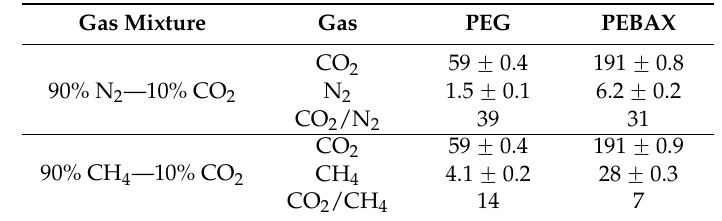
Table 3. Gas permeability (Barrer) through PEG and PEBAX membranes under dry mixed gas conditions at 35 ˝ C and 600 kPa.